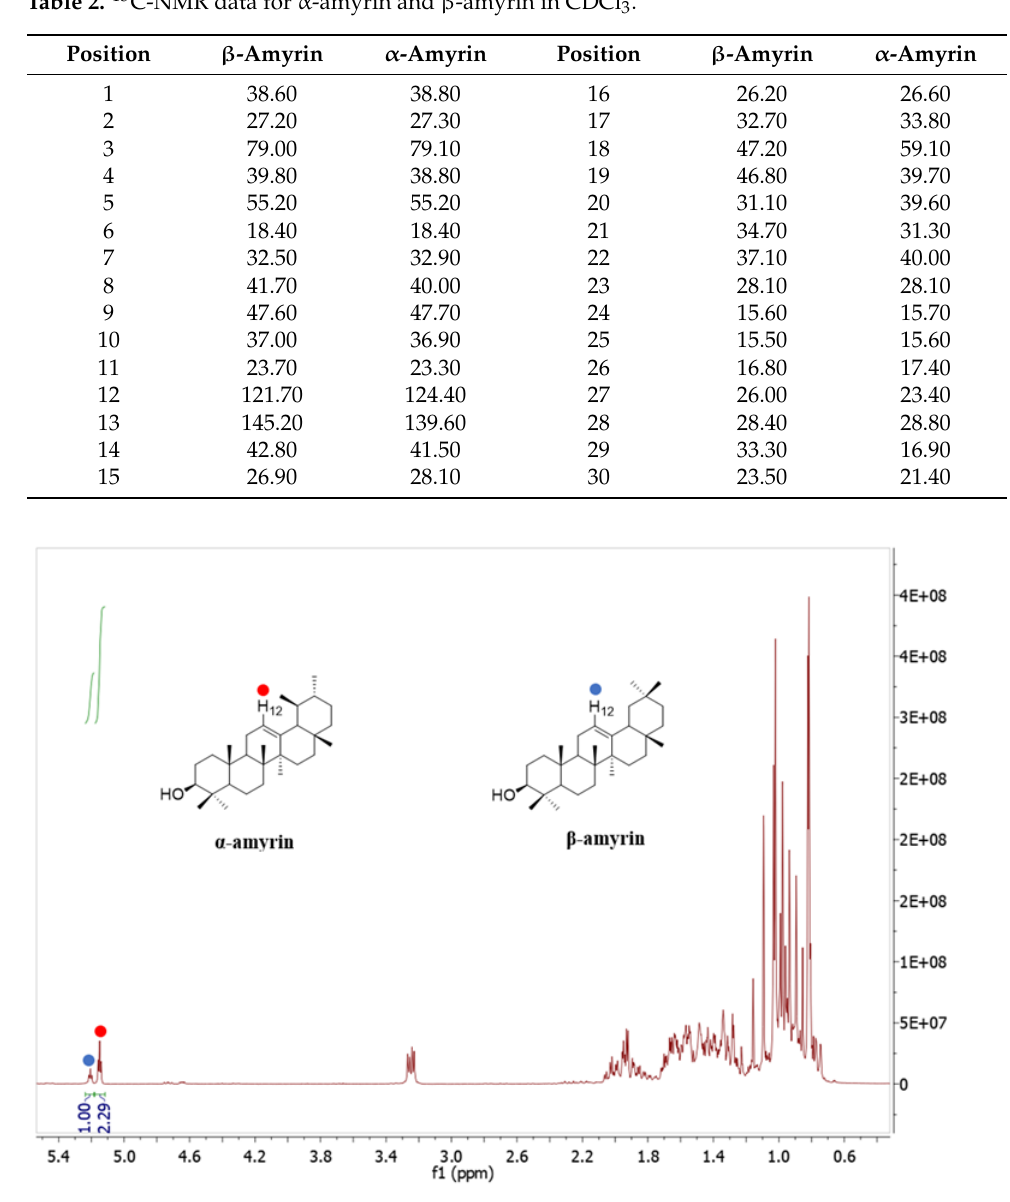
Figure 4. 1 H- NMR spectrum of the mixture of α - amyrin and β -amyrin measured in CDCl 3 (400 Figure 4. 1 H-NMR spectrum of the mixture of α -amyrin and β -amyrin measured in CDCl 3 MHz). (400 MHz).